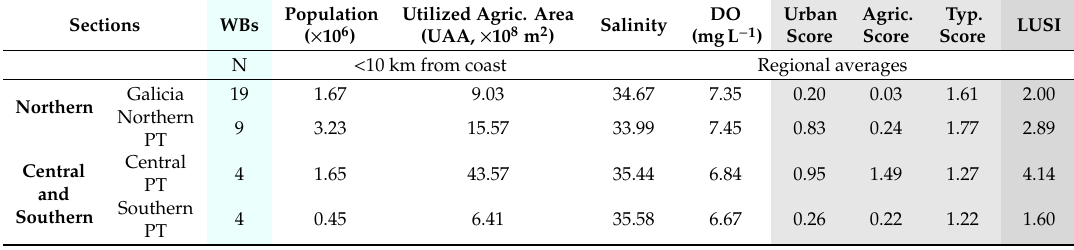
Table 4. Regional values of population ( × 10 6 inhabitants) and Utilized Agricultural Area (UAA; × 10 8 m 2 ). Salinity and dissolved oxygen (DO; mg L − 1 ) are presented as regional averages. Urban, Agriculture, and Typology scores, as well as the final Land-Uses Simplified Index (LUSI) index, are also presented as regional averages. The number (N) of Water Bodies (WBs) considered in each region is provided. Please note that figures provided for population and UAA refer to land located < 10 km from the coast.